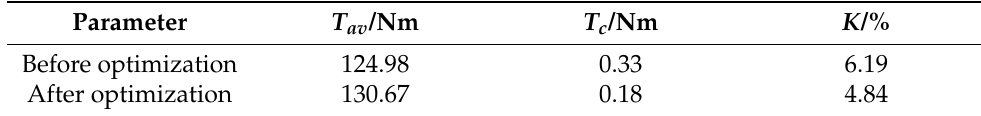
Table 12. Comparison of various performance indexes before and after optimization.